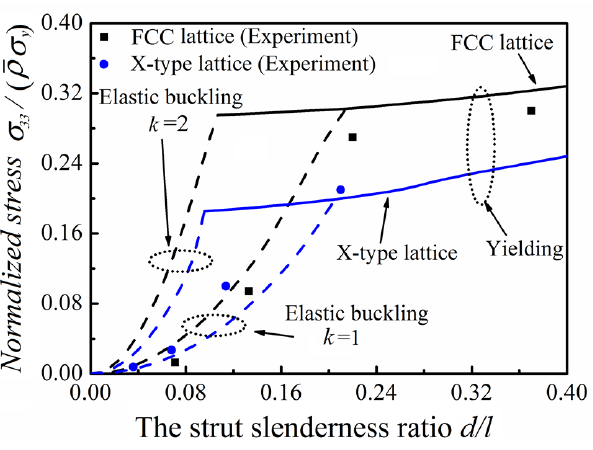
Figure 7. The variation in peak stress of structure with relative density.